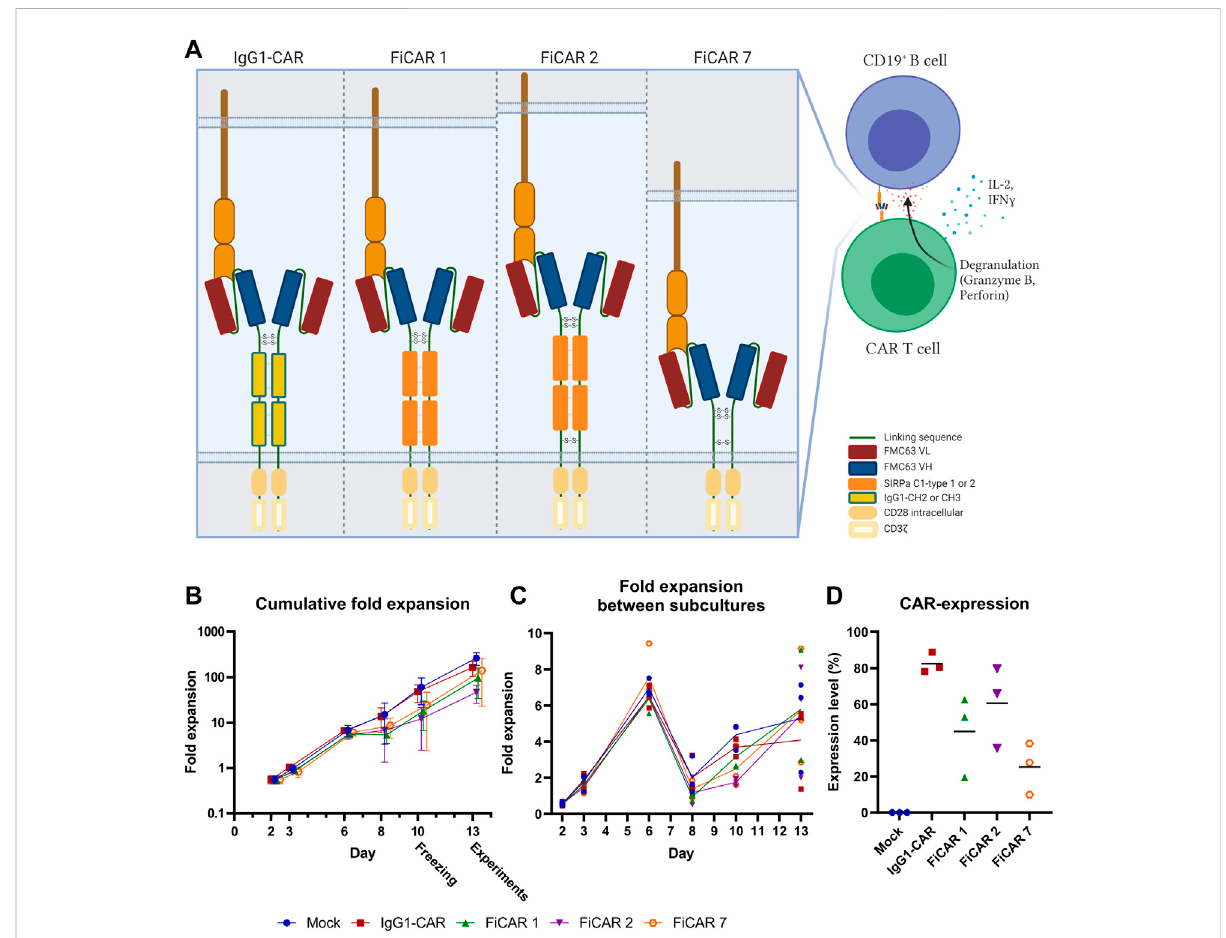
FIGURE 1 Schematic fi gure of CARs and T cell expansion kinetics ( n = 3). (A) Estimated CAR structures in a schematic model. The indicated disul fi de bridgesarehypothetical. (B) Tcellexpansion wasassessedwithtrypanblueandcountedwithBio-RadTC20AutomatedCellCounterondays2,3,6, 8, 10, and 13 prior to subculturing the cells. Results are shown as mean values with standard deviation (C) Fold expansion of the cells between subcultures was assessed every 2-3 days. The lines represent mean values of the different CAR T cells. (D) CAR expression on day 13 was analyzed by fl ow cytometry. Results show individual data points and mean values (horizontal